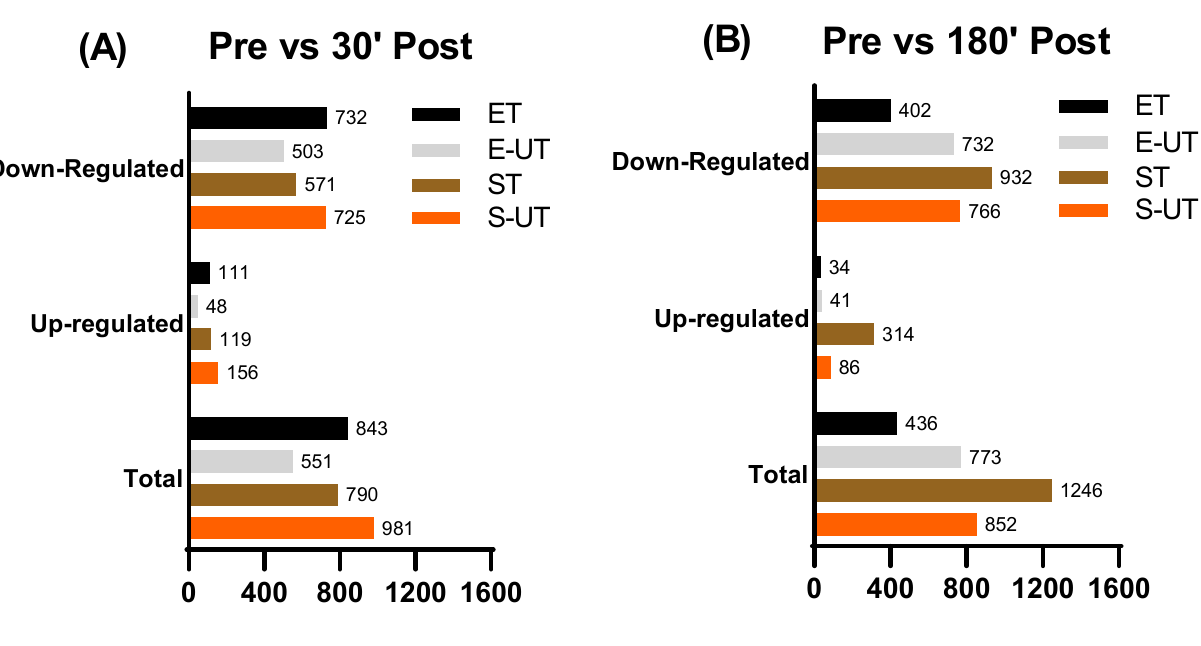
Figure 2. Number of differentially expressed genes in response to the exercise test (endurance or strength) ( A ) Pre vs. 30 ′ Post and ( B ) Pre vs. 180 ′ Post. The total number of differentially expressed genes in skeletal muscle of highly endurance- trained (ET) participants is higher at Pre vs. 30 ′ Post compared to Pre vs. 180 ′ Post, while a higher number of differentially regulated genes is noted at Pre vs. 180 ′ Post for ST. There is no major difference between Pre vs. 30 ′ Post or Pre vs. 180 ′ Post for the untrained control groups (E-UT and S-UT). 30 ′ Post vs. 180 ′ Post results are provided in Supplementary Ma- terials.